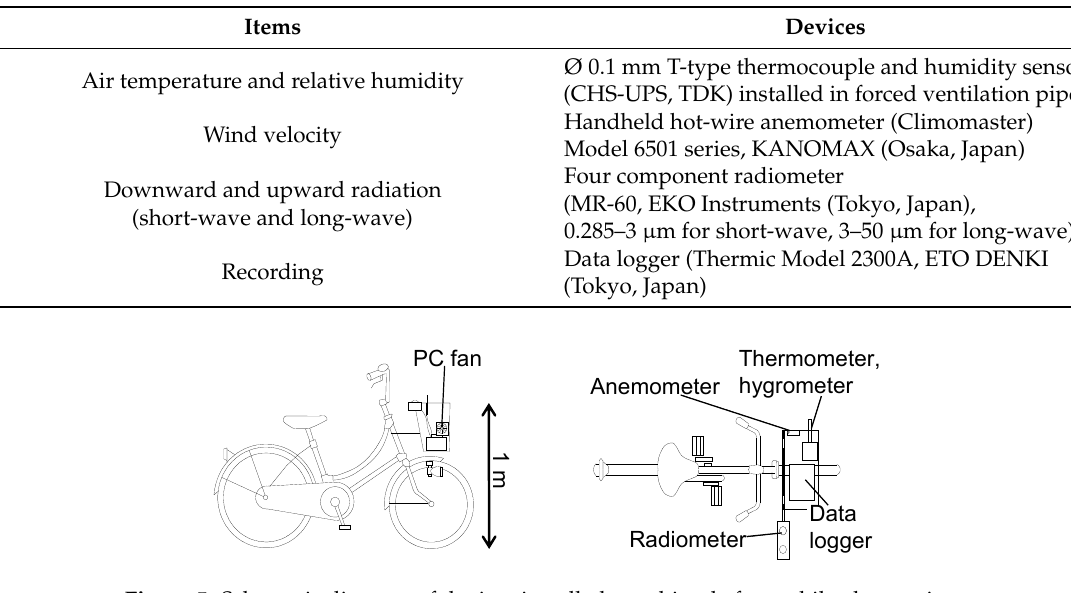
Figure 5. Schematic diagram of devices installed on a bicycle for mobile observations.